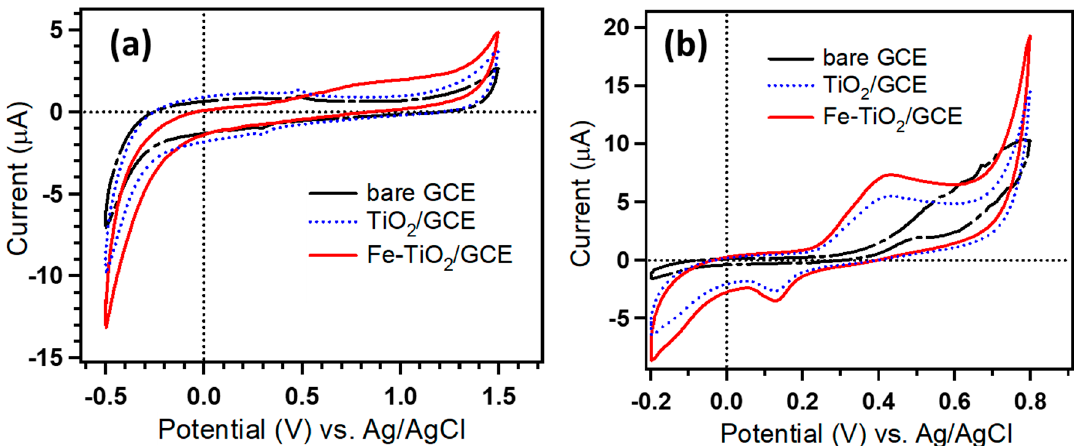
Figure 4. Cyclic voltammograms measured at 50 mVs − 1 in 0.1 M phosphate buffer solution (PBS) (pH 7.4) ( a ) with absence of hydrazine and ( b ) in presence of 0.5 mM hydrazine using bare glassy carbon electrode (GCE), TiO 2 modified GCE and Fe-doped TiO 2 modified GCE.